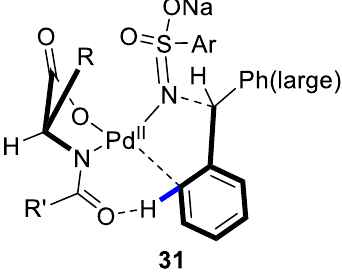
Figure 4. Proposed transition state. Reproduced from Reference [78].